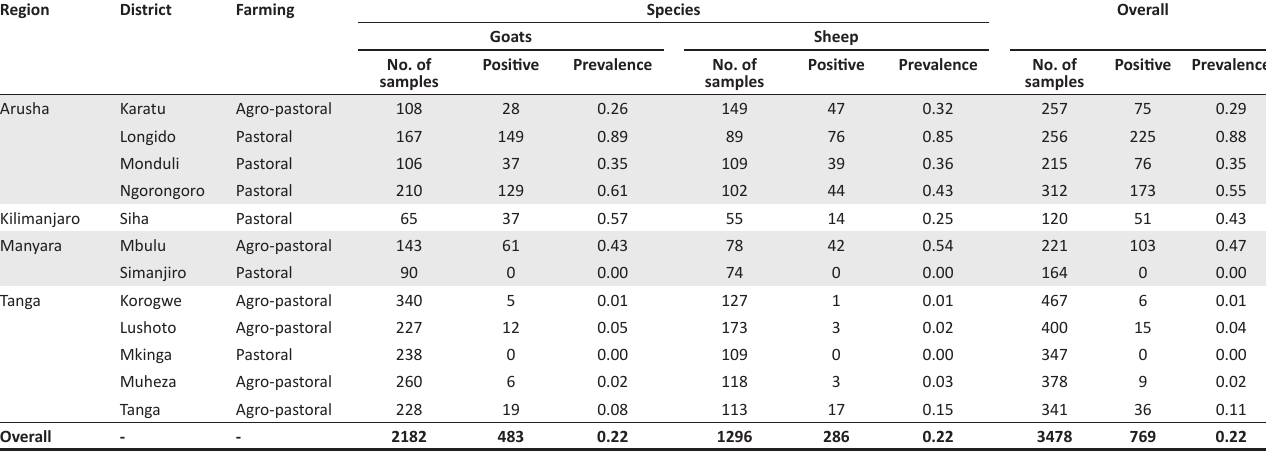
TABLE 1: Seroprevalence of peste des petits ruminants in sheep and goats according to sampling area. Region District